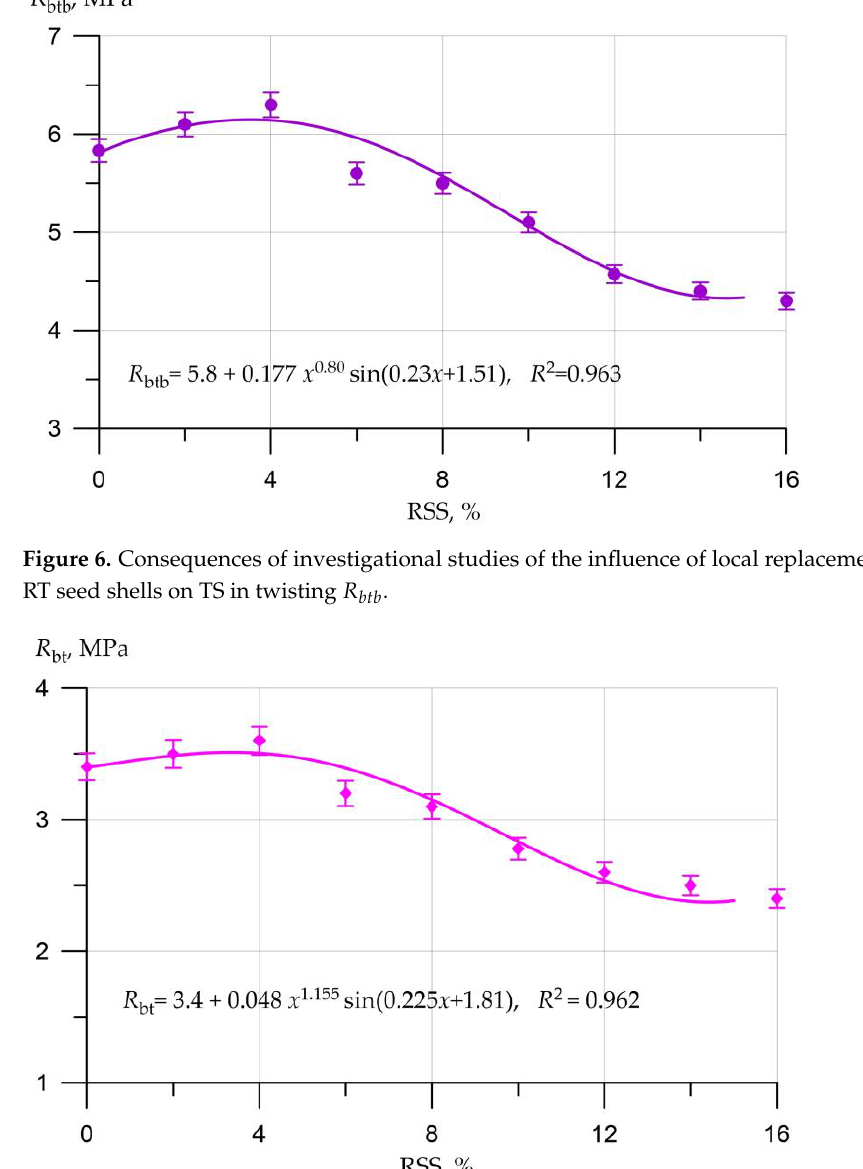
Figure 7. Results of investigational studies of the influence of local replacement of CA with RT seed shells on axial TS R bt